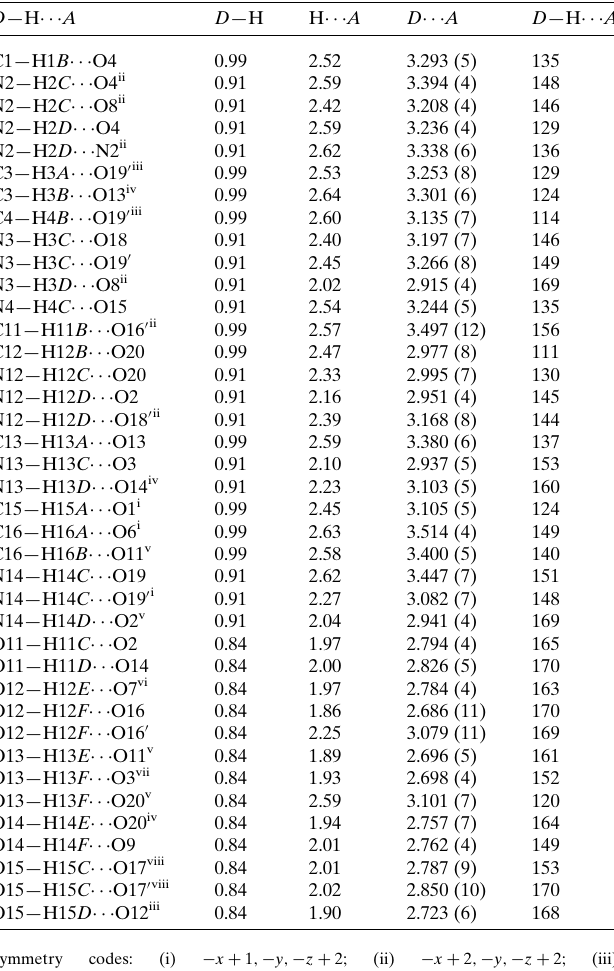
Table 2 Hydrogen-bond geometry (A˚ , (cid:5) ).